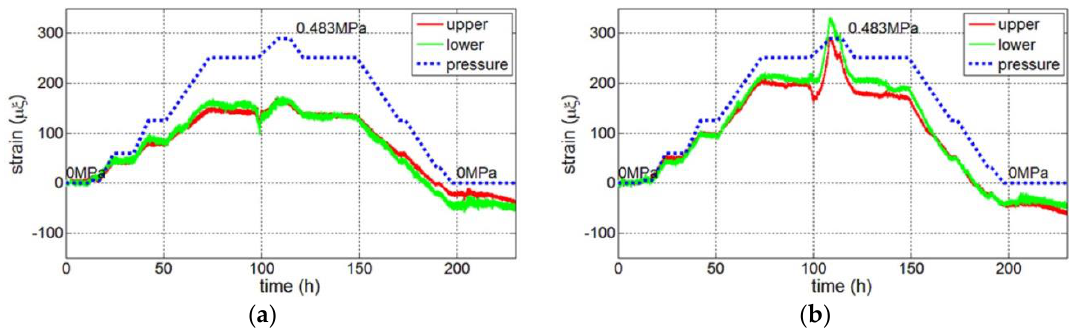
Figure 9. The strain of two crack measuring points. ( a ) Crack No. 1; ( b ) Crack No. 2. Appl. Sci. 2017 , 7 , 419